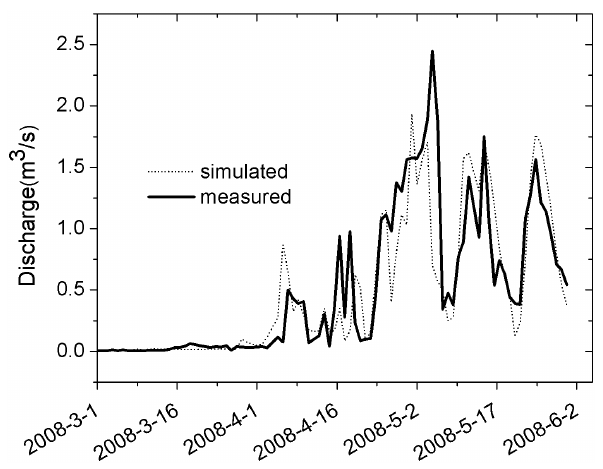
Fig. 5. Contrast between simulated and measured